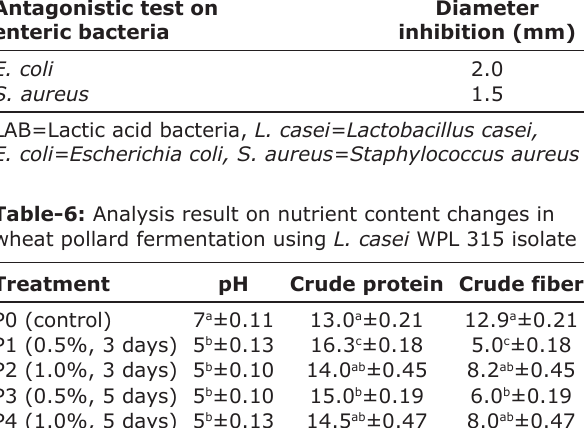
Table-5: LAB survival test on E. coli and S. aureus Antagonistic test on enteric bacteria